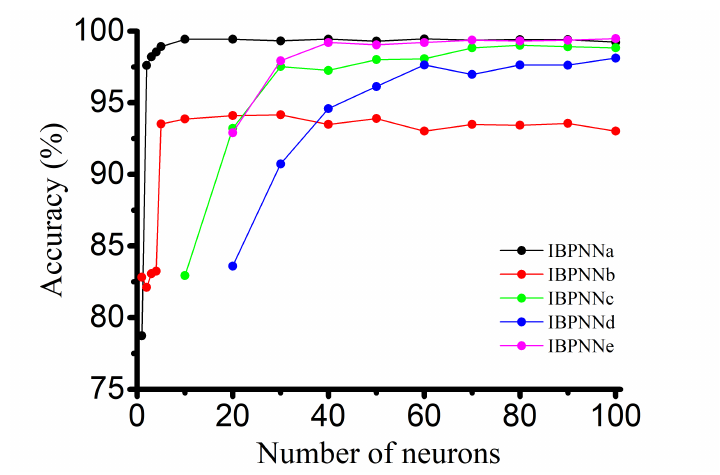
Figure 8. Neuron number